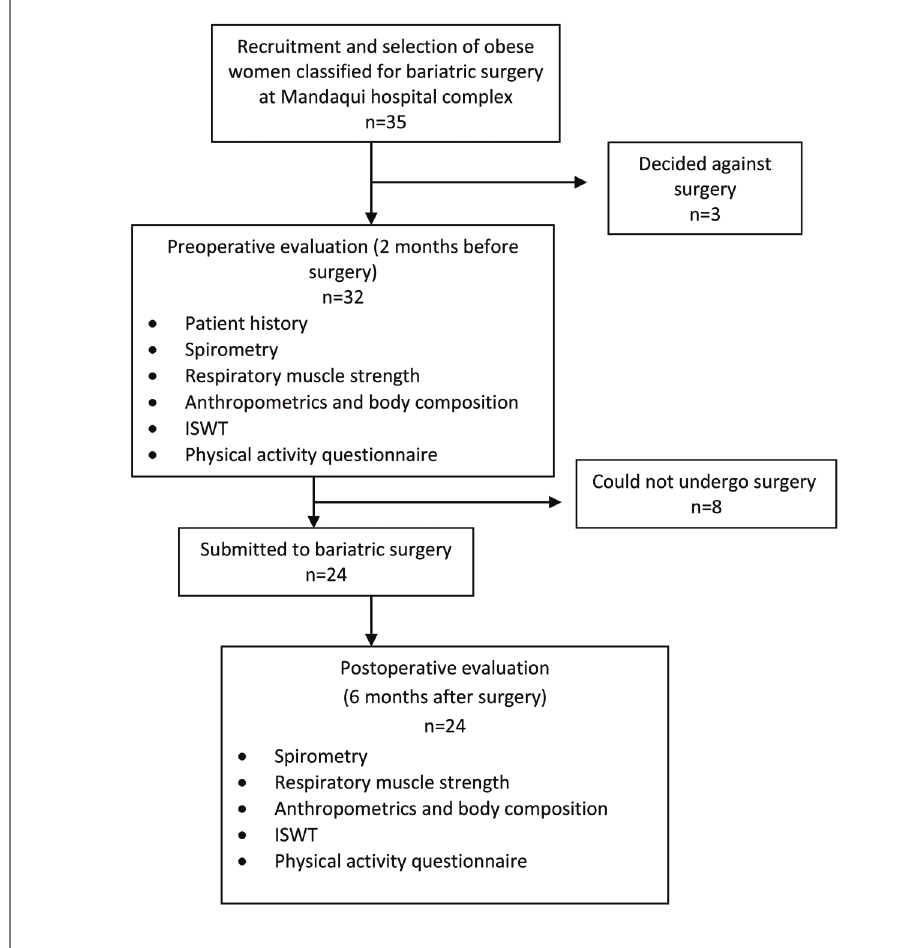
Figure 1 - Flowchart of the